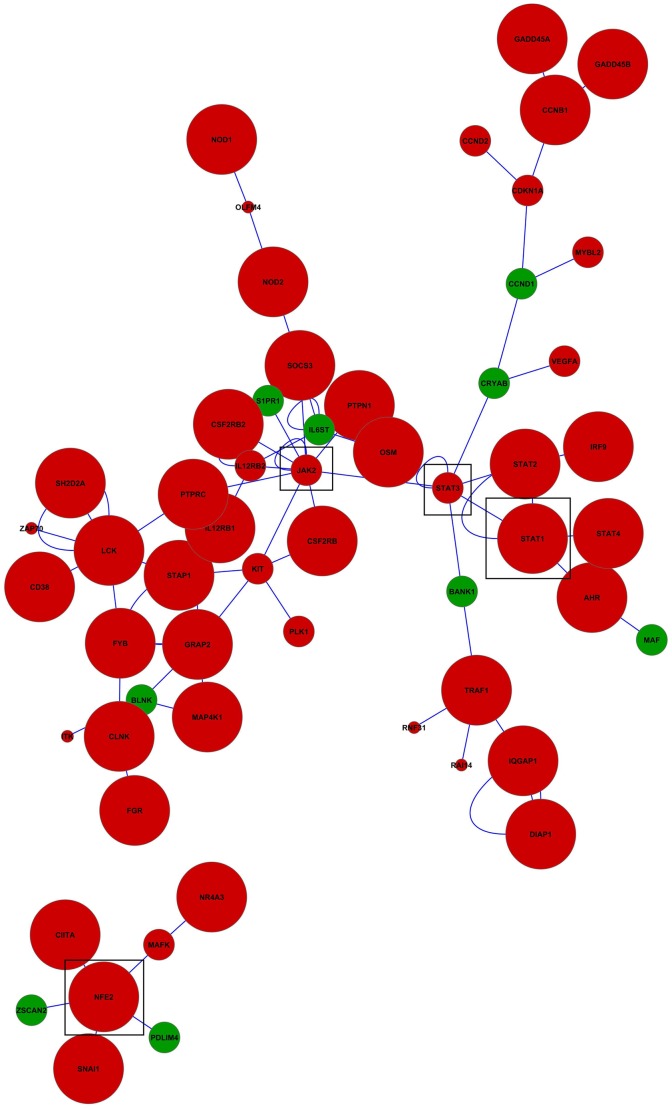
Network of genes differentially expressed between BCG-challenged and Control mice in microglia.Red (green) nodes denote genes over- (under-) expressed in BCG-challenged relative to Control mice. Node size represents the P-value were larger nodes indicates more extreme significance (FDR-adjusted P-value < 0.001 larger nodes; P-value < 0.05 intermediate nodes; P-value < 0.1 small nodes). Edges denote known relationships between genes in the SysBiomics repository. Framed genes (squares) are discussed in the manuscript.